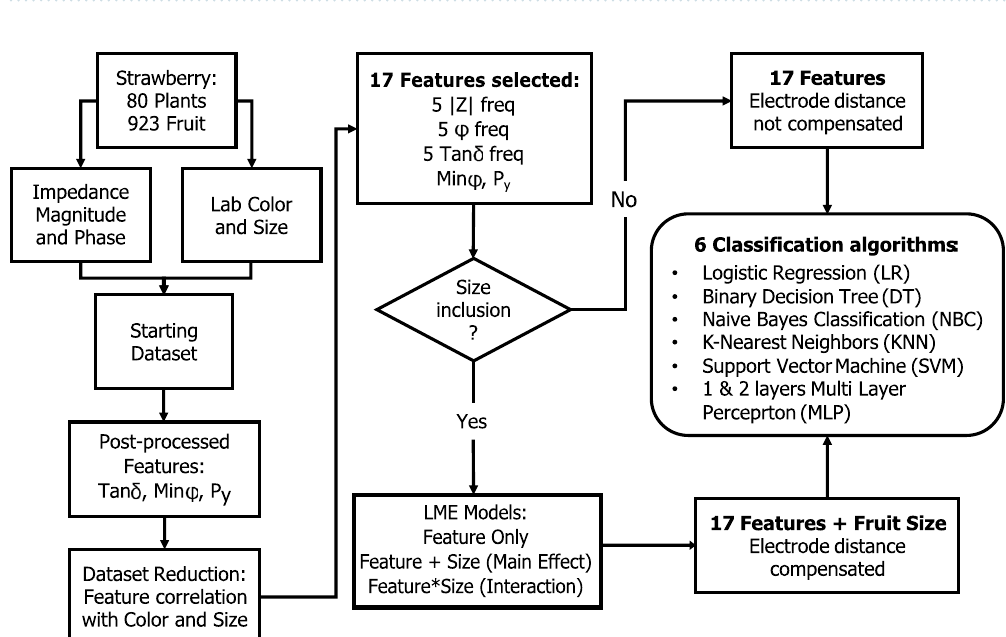
Figure 2. Overview of the methodology used for the investigation of the most relevant features of the bioimpedance dataset, also including the fruit size as additional feature to compensate the electrode distancing, to be used to train the classification